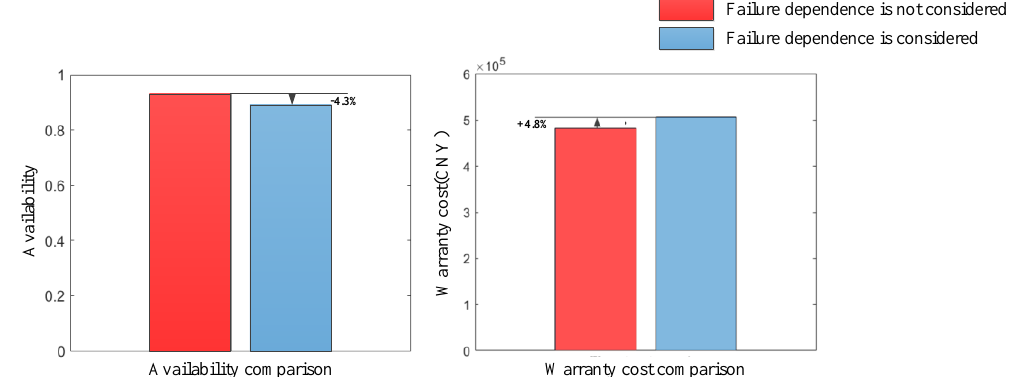
Figure 17. Comparison between situations considering failure dependence and not considering failure dependence.